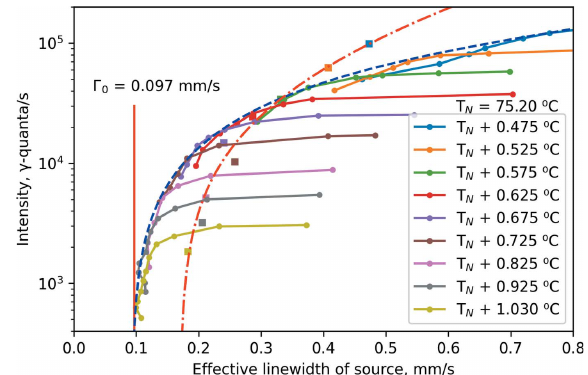
Figure 5 The master plot of all experimental data in the width–intensity representation. The solid lines connect data points (circles) measured at fixed temperatures for various angles. The displacement of solid lines from the bottom-left to top-right corners corresponds to decreasing of the angular position (cid:4) . The envelope (blue dashed line) shows the maximum available intensity at specified effective width of the source. The squares connected by the red dash-dot line show the data points measured for (cid:4) = 0 angular position at indicated temperatures. The red solid vertical line shows the natural width (cid:2) 0 .